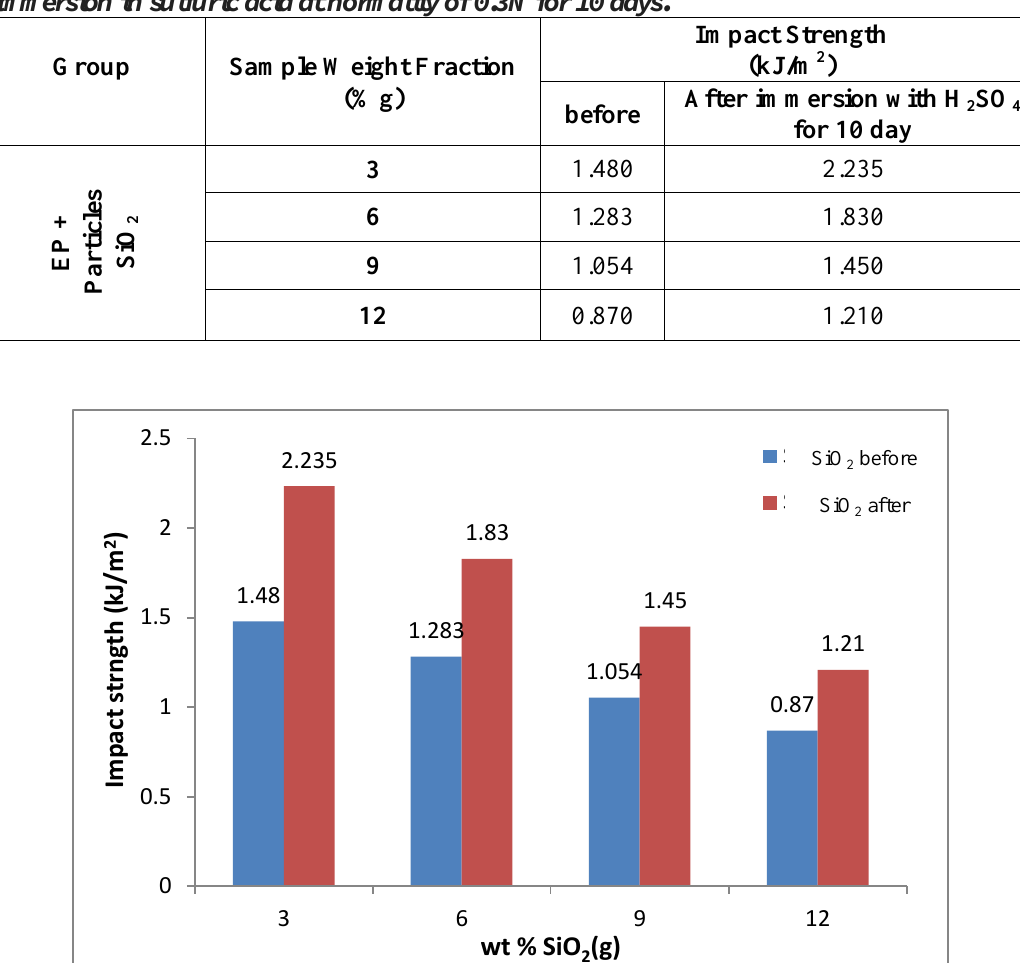
Fig.6: Shows the comparison of the Impact strength values of SiO